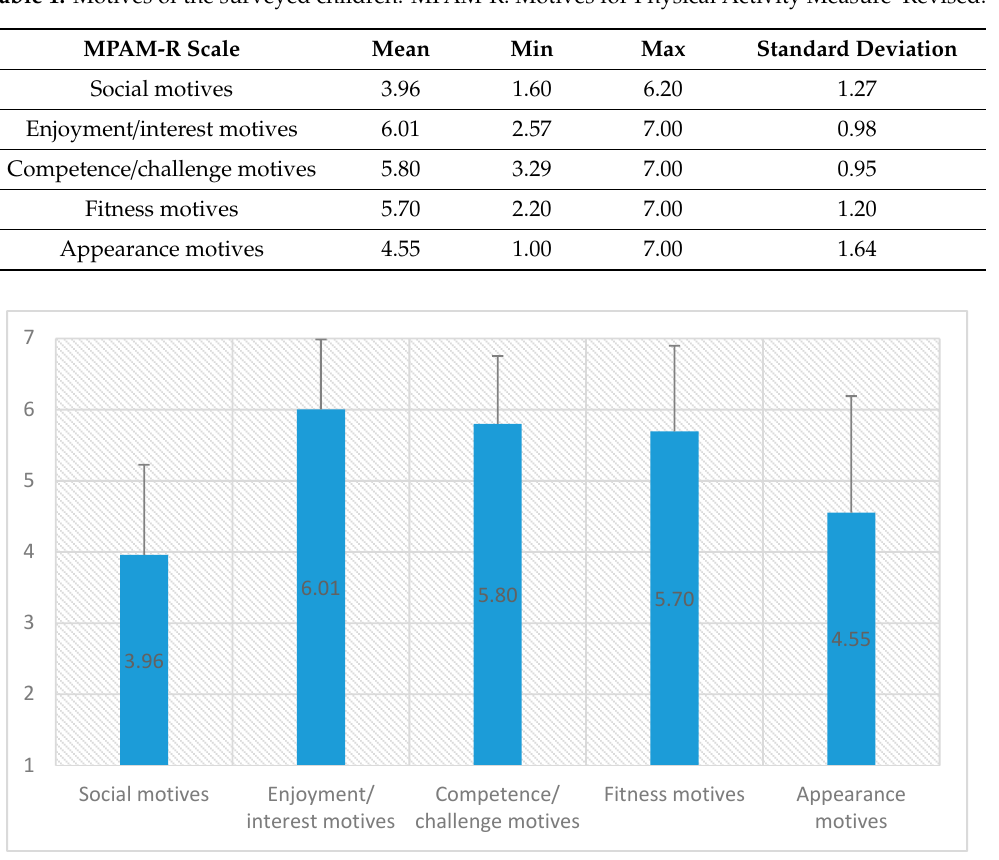
Figure 1. Motives of the children being surveyed.